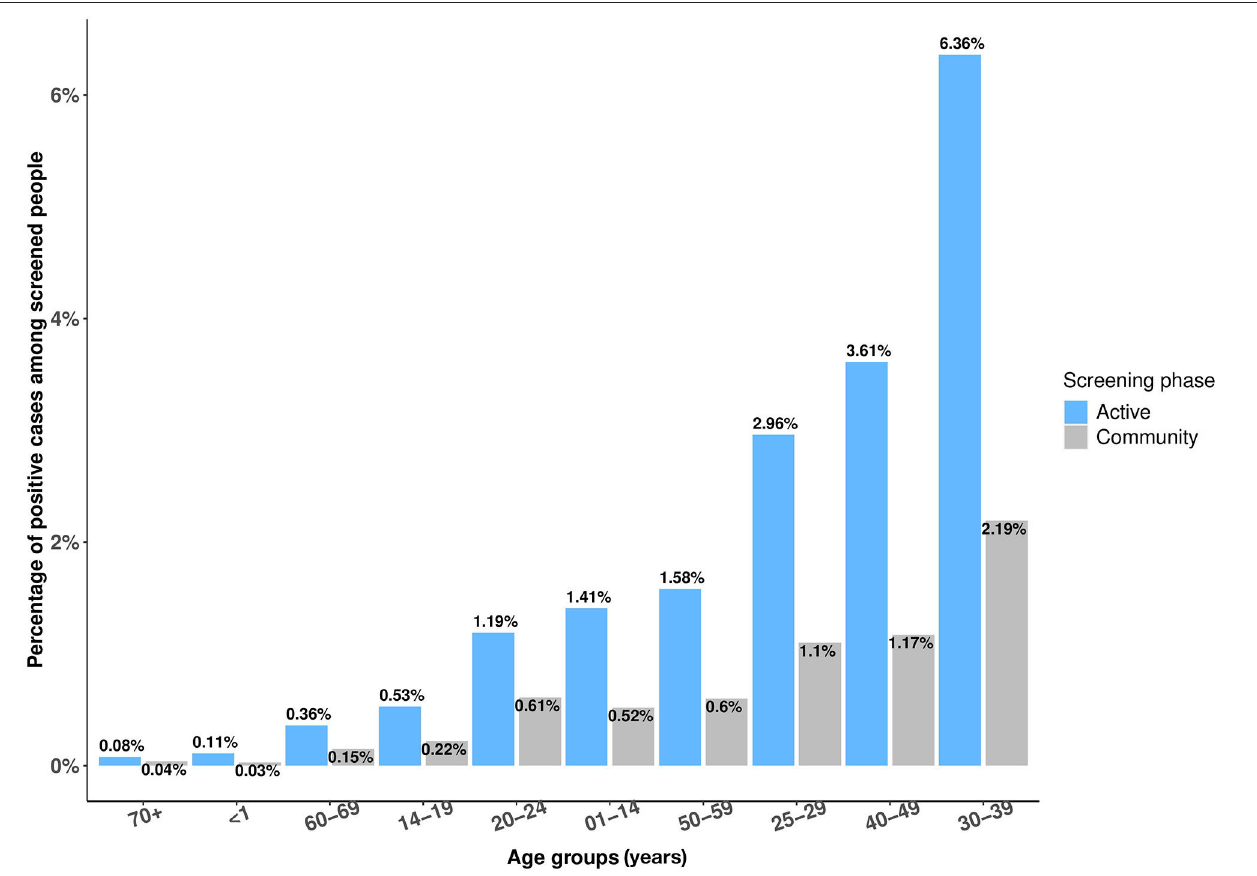
FIGURE 2 | The percentage of positive COVID-19 cases among all screened individuals in Saudi Arabia between 16 April − 19 May 2020 in active and community phases in terms of age groups.